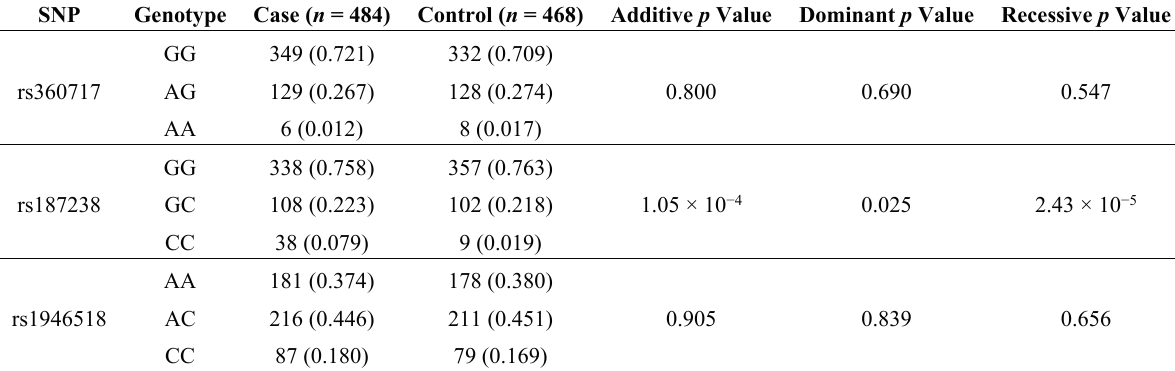
Table 2. Association between three SNPs in the promoter region of IL-18 gene and risk for idiopathic recurrent miscarriage in Chinese Han population.